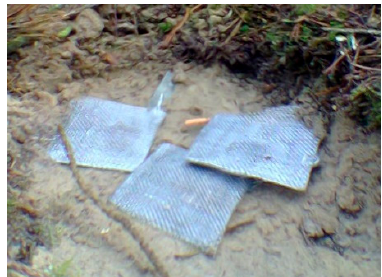
Figure 2. Seed nets containing one layer of seeds.